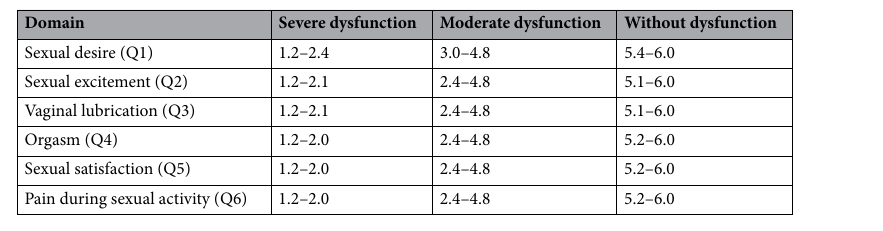
Table 2. Classification of female sexual function through the domains of the Female Sexual Function Index and values assigned to each domain by this index.